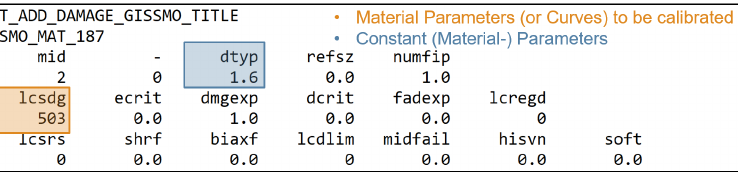
Figure 2. Exemplary illustration of the material card MAT_ADD_DAMAGE_GISSMO used in this